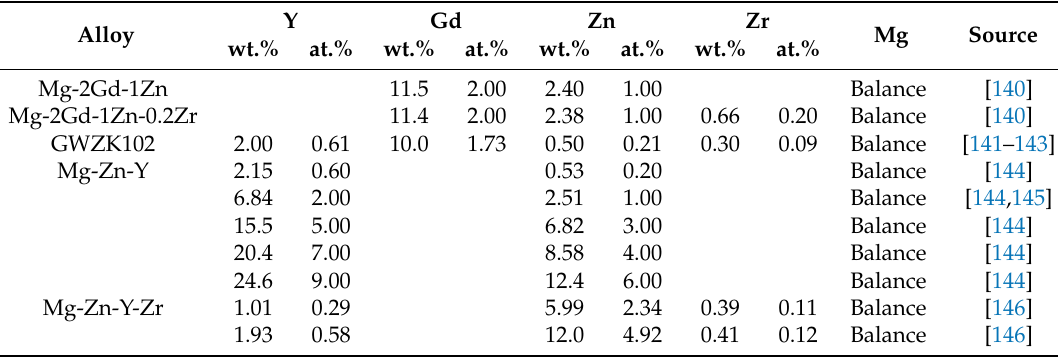
Table 3. Overview of the chemical compositions of the investigated alloys in the works reviewed in Section 7.2 given in wt.% and